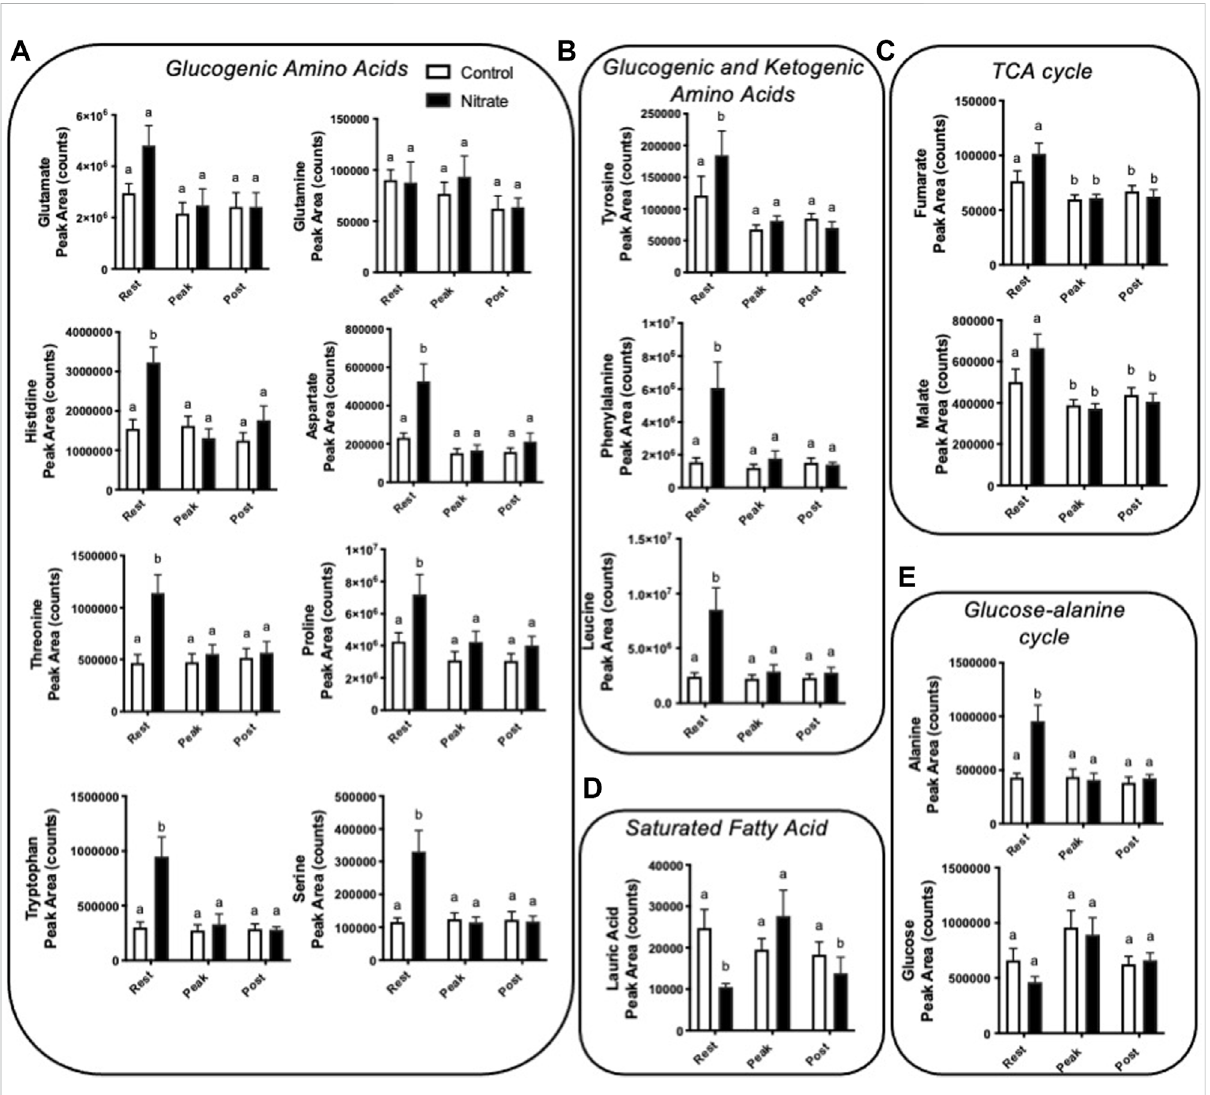
FIGURE 3 Nitrate exposure increased metabolites involved in amino acid metabolism, fatty acid metabolism, and the TCA cycle in liver. Labeled means without a common letter differ. (One-way ANOVA with Fisher ’ s post-hoc and Holm FDR-correction, p < 0.1 indicating signi fi cance, n = 7 –